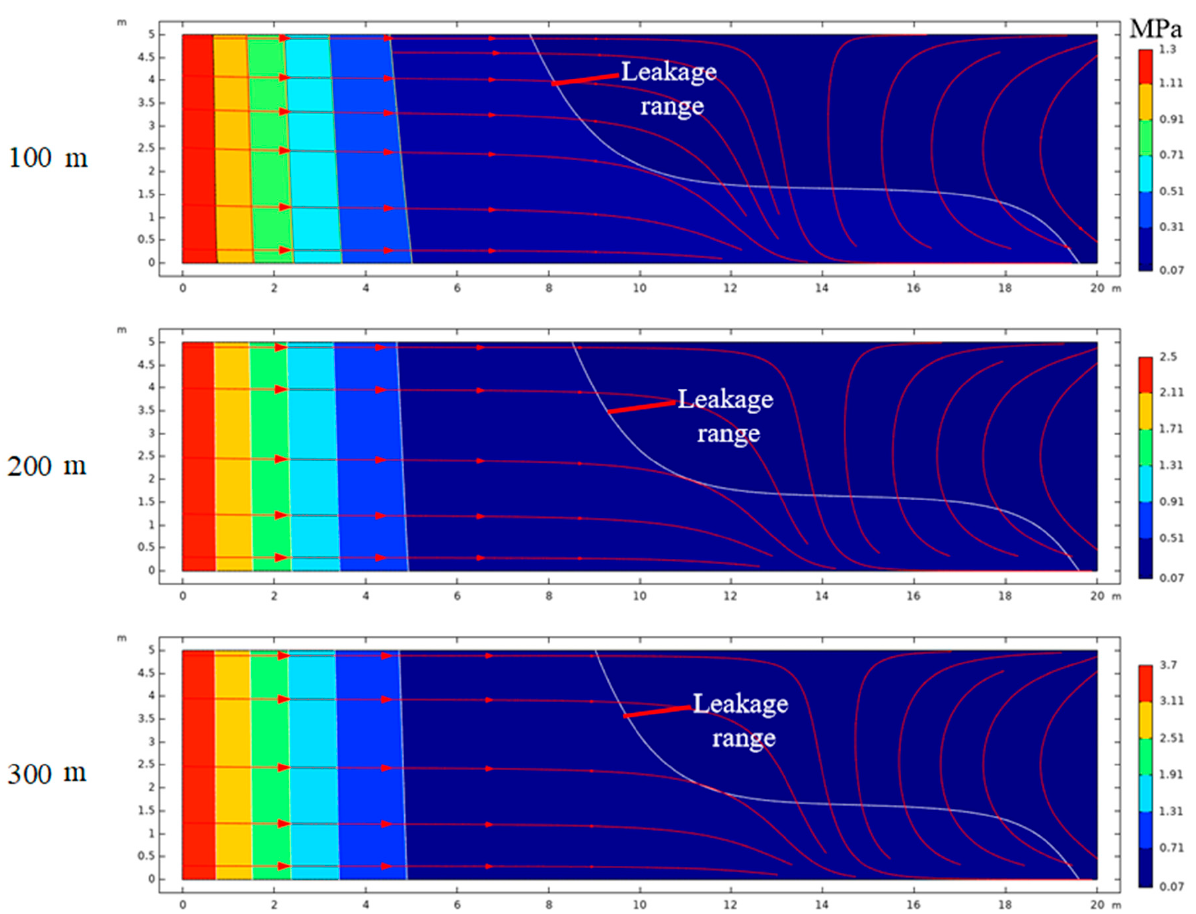
Figure 5. Distribution of seepage range in the coal pillar dam with different depths (Unit: MPa).